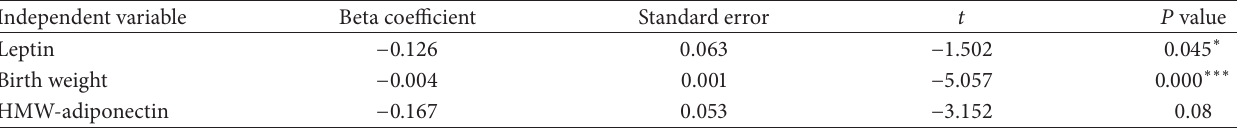
Table 4: Multivariate stepwise linear regression analysis with insulin sensitivity index (G/I) as dependent